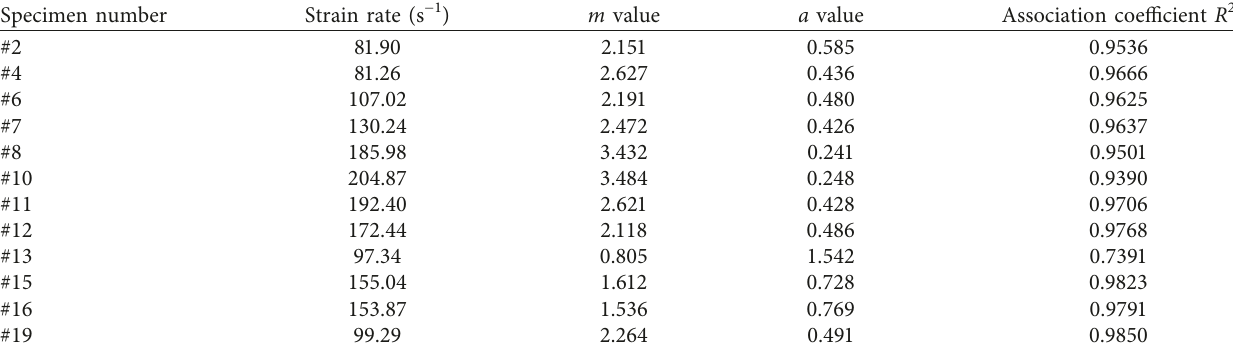
Table 2: Fitting result of the improved statistical damage constitutive